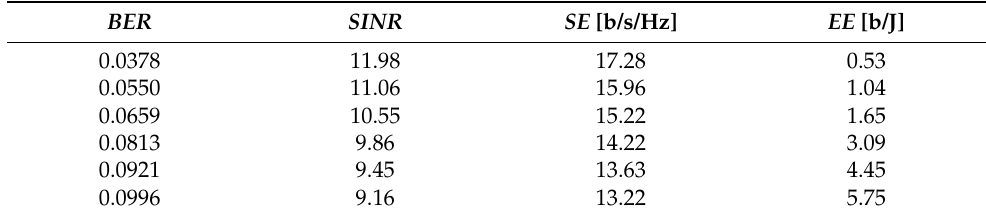
Table 2. Simulation results (after averaging).